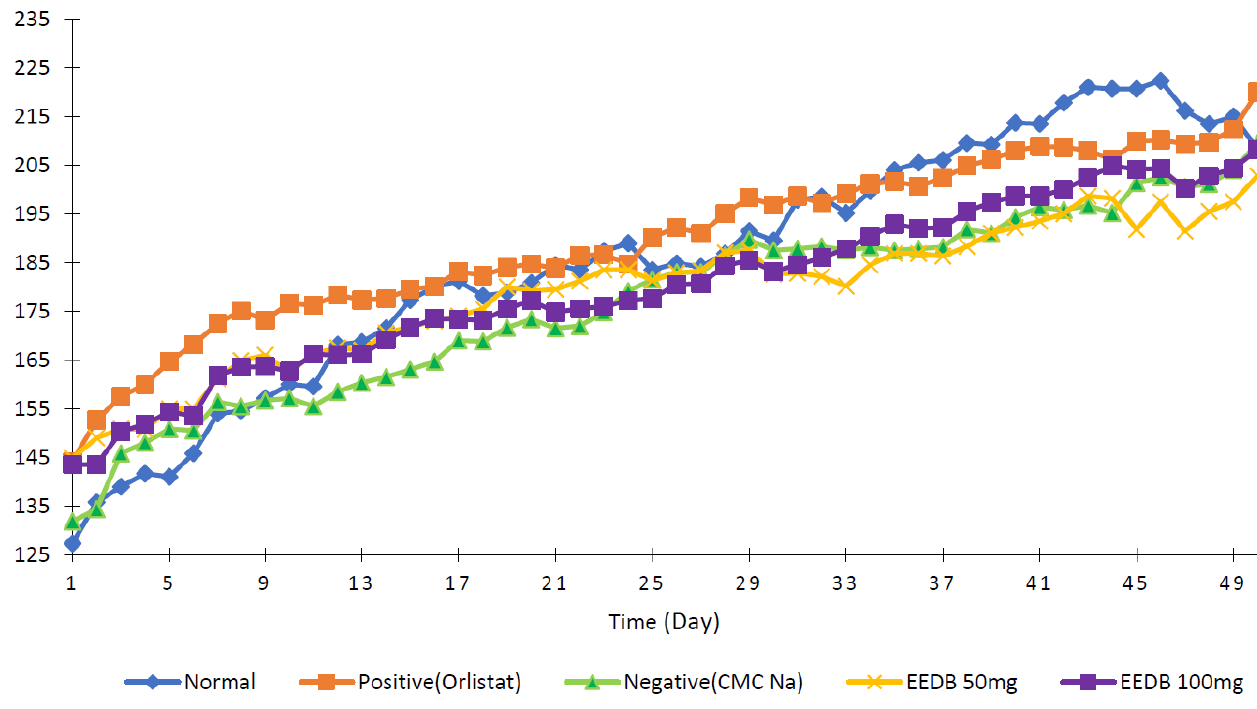
175 Figure 4. Body weight change percentage of each group after 50 days of HFD induction and 20 days 176 of treatment compared to day 0. 177